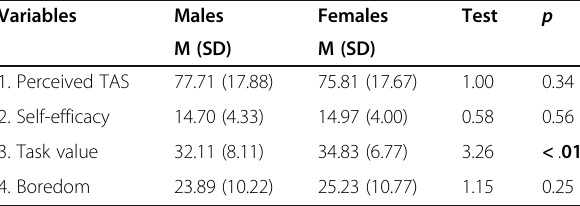
Table 2 Descriptive statistics and t -statistics for gender differences among the study variables